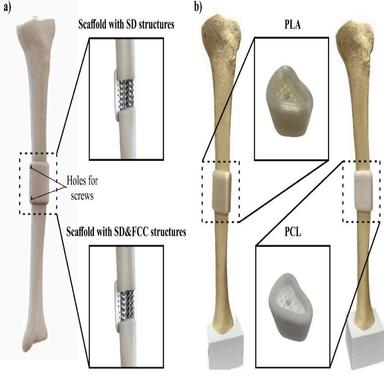
Illustration of the scaffolds assembly coupled with superimposed images from the internal structure: a) 3D render digital model b) Physical 3D printed scaffolds; c) Indicative images of scaffolds internal structure for PLA and PCL.